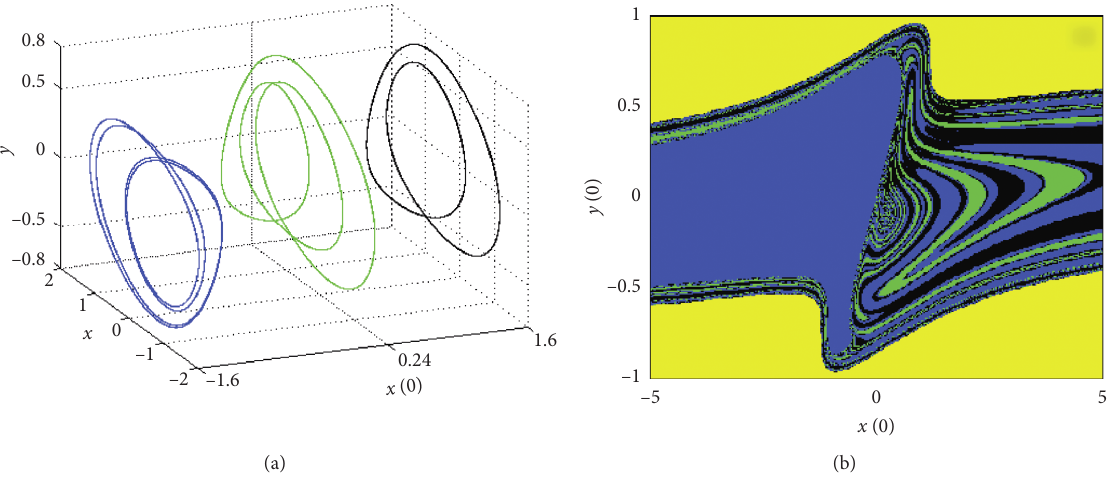
Figure 6: (a) Coexistence of three asymmetric periodic attractors showing multistability phenomenon with the basin of attraction (b) in the plane ( x ( 0 ) , y ( 0 )) when δ � 0 .